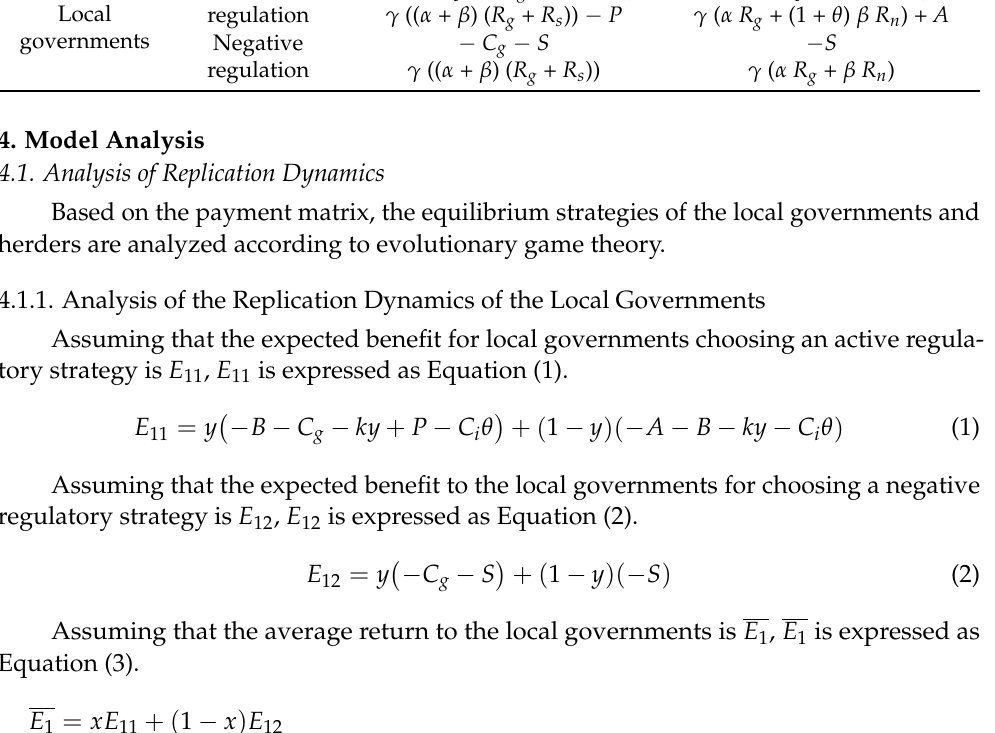
Herders Overgrazing Moderate